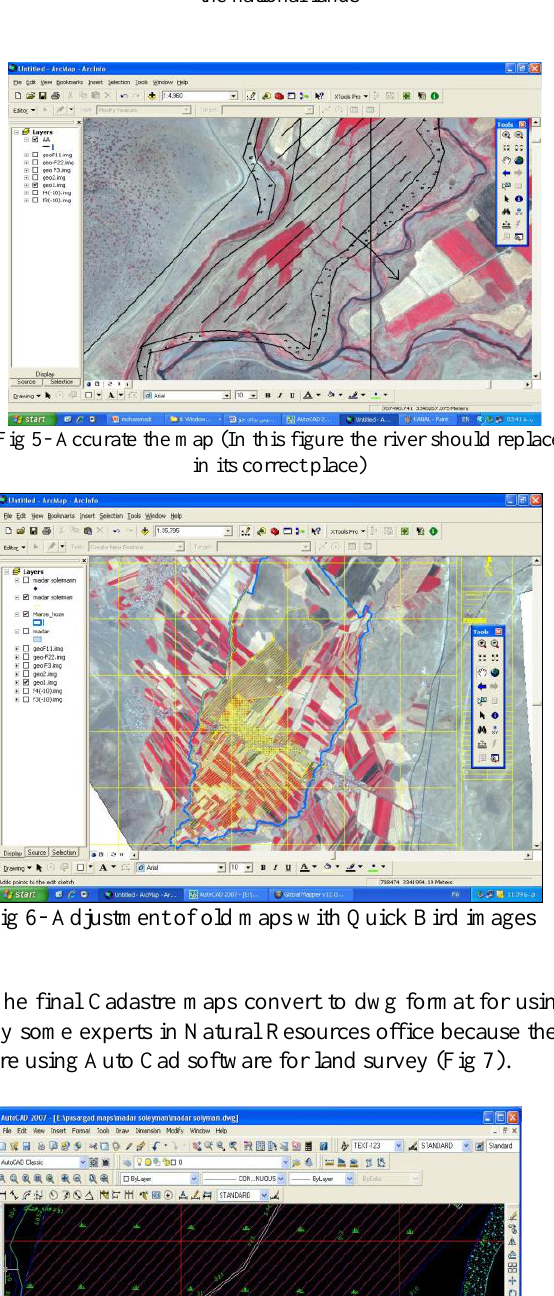
Fig 4- digit and determination of different lands and separating the national lands